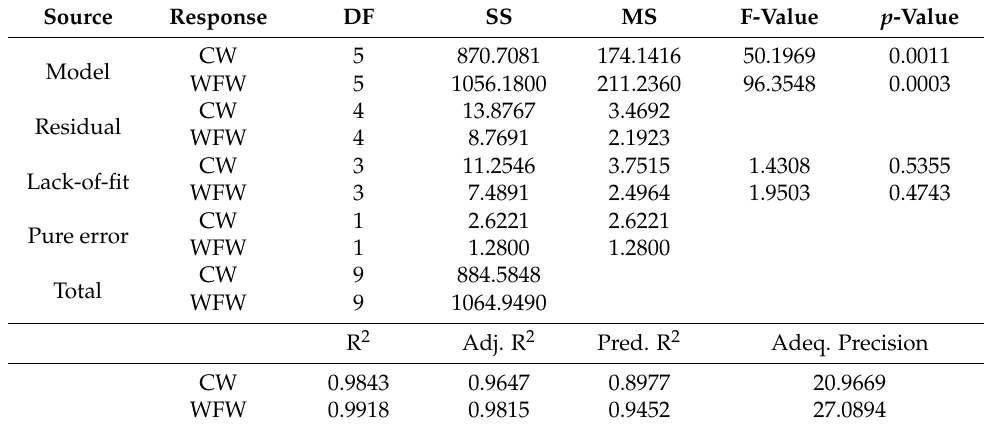
Table 3. Analysis of variance (ANOVA) for flocculation efficiency.